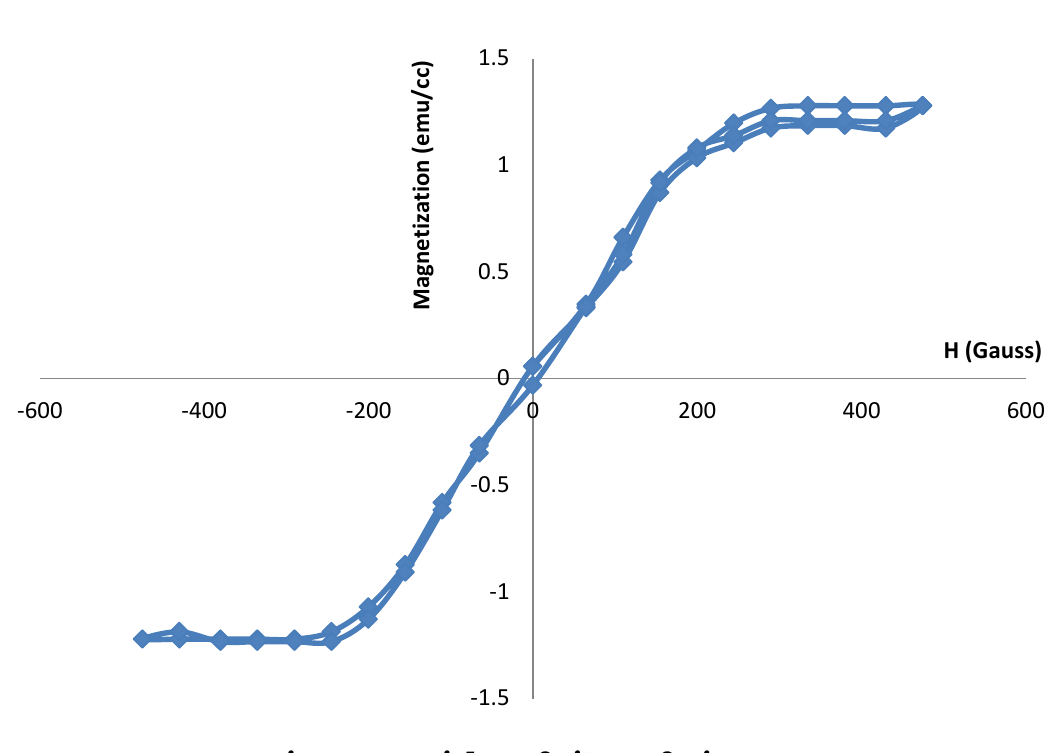
Fig.7: Hysteresis loop of NiZnMn ferrite.